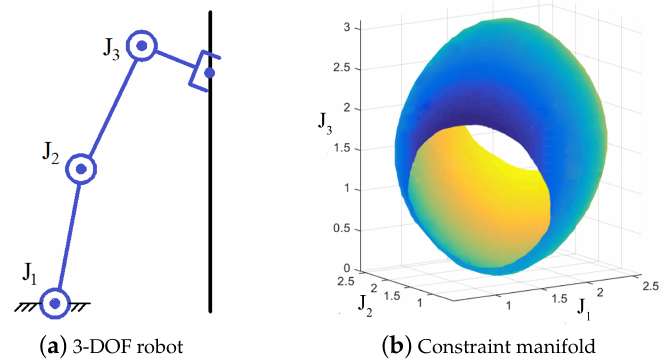
Figure 1. ( a ) The end effector of a three-DOF robot is constrained on the black line, which means that the robot has only two-DOF in the workspace. ( b ) The configurations satisfying the constraint form a two-dimensional manifold in the C-space. Obviously, This manifold has zero measure with respect to ambient space metric and can not be expressed by an analytic formula, because the mapping between configuration space and workspace is